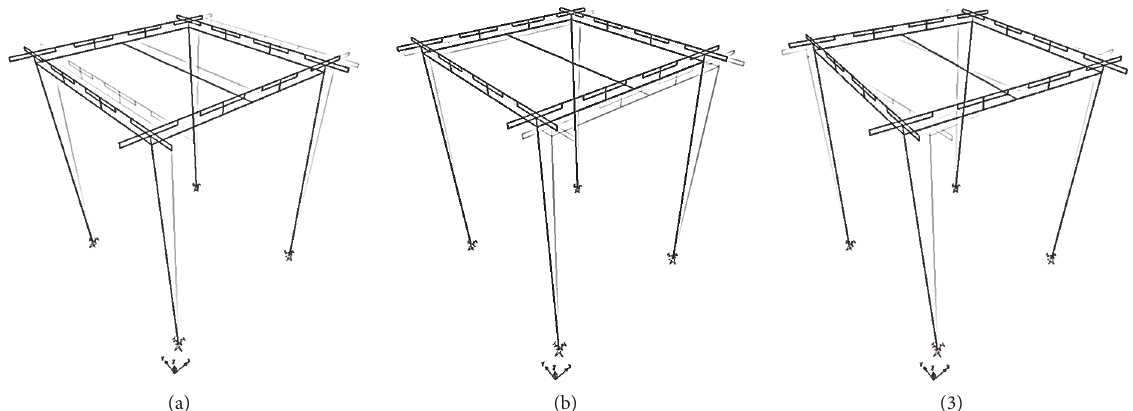
Figure 16: Mode shapes of the first 3 orders: (a) 1st mode; (b) 2nd mode; (3) 3rd mode.